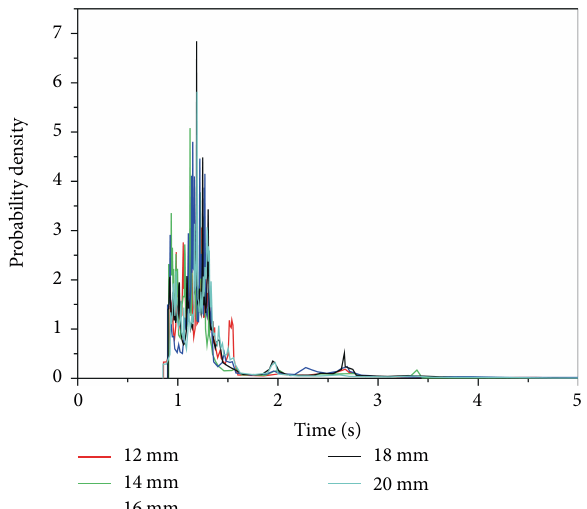
Figure 15: Influence of rotor pitch on residence time distribution.